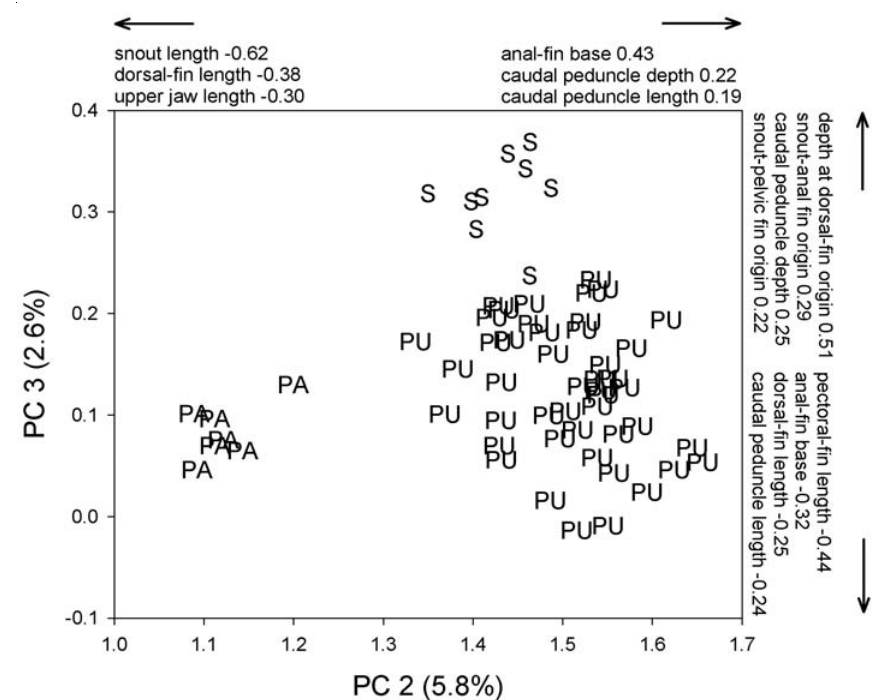
Fig. 26. Principal component analysis of the 17 morphometric measurements of males of Odontostilbe pulchra (PU), Odontostilbe splendida (S), and Odontostilbe pao (PA). Stronger loadings on the second and third principal components (PC2, PC3).